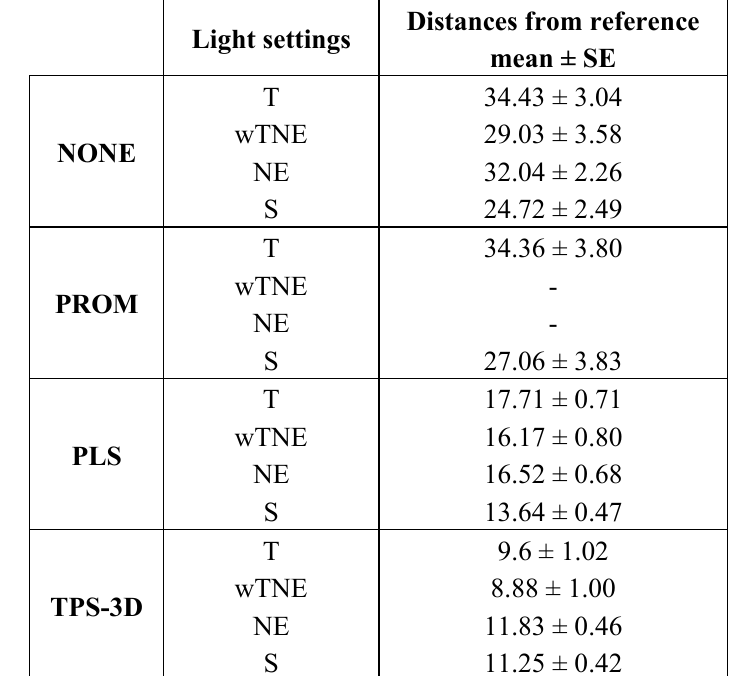
Table 3. Results of the Calibration Experiments (Light Settings): values refer to the performance of the calibration methods taking into account the light settings (see Table 1 for codes).